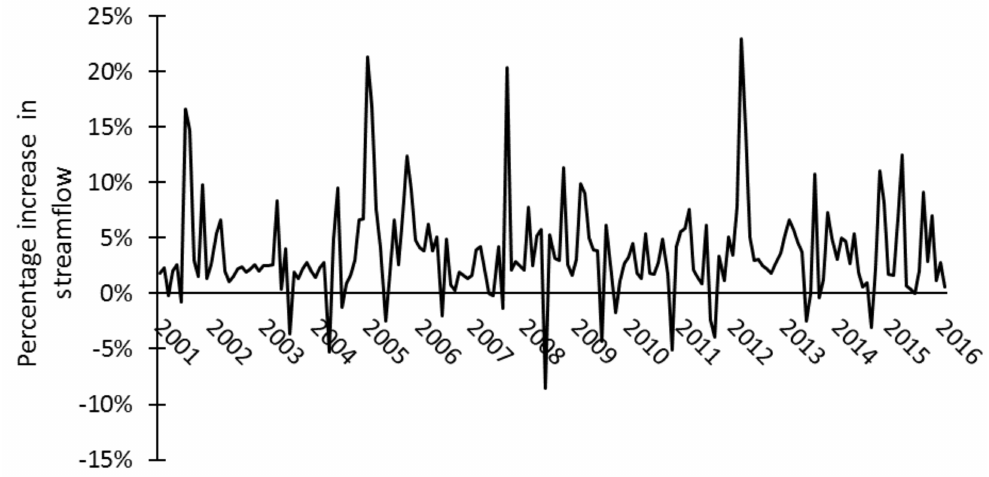
Figure 15. The percentage increase of streamflow between the reduced irrigation scenario and the baseline scenario indicates the impact of irrigation results to streamflow at the outlet of the watershed. The percentage increase in return flow for each of the river cells during the simulation period is shown in Figure 16, with green–yellow–red bars representing groundwater return flow. It can be seen from this figure that the majority of river cells are gaining return flows for the reduced irrigation scenario, with the highest percentage increase of 31%. This is an important result—implementing a basin-wide decrease in irrigation water for both surface water irrigation and groundwater irrigation does not necessarily improve waterlogging occurrence, and can actually increase the groundwater loading of salts, nitrate, phosphorus, and trace elements (selenium, uranium) due to an increase in groundwater return flow. This may be due to the close proximity of the pumping wells to the Arkansas River; therefore, the areas that control groundwater discharge to the Arkansas River have higher water tables than those in the baseline scenarios. However, in general, a targeted approach must be taken that focuses on decreasing surface water irrigation and allowing the groundwater pumps to continue operation. This will maintain deep water tables and decrease the recharge, therefore preventing